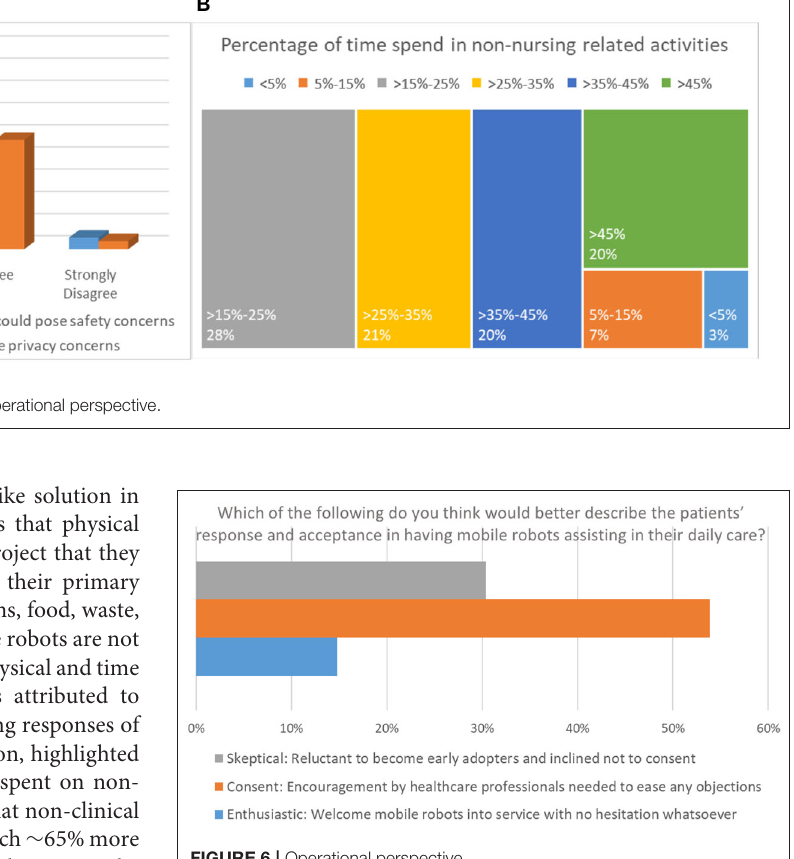
FIGURE 6 | Operational